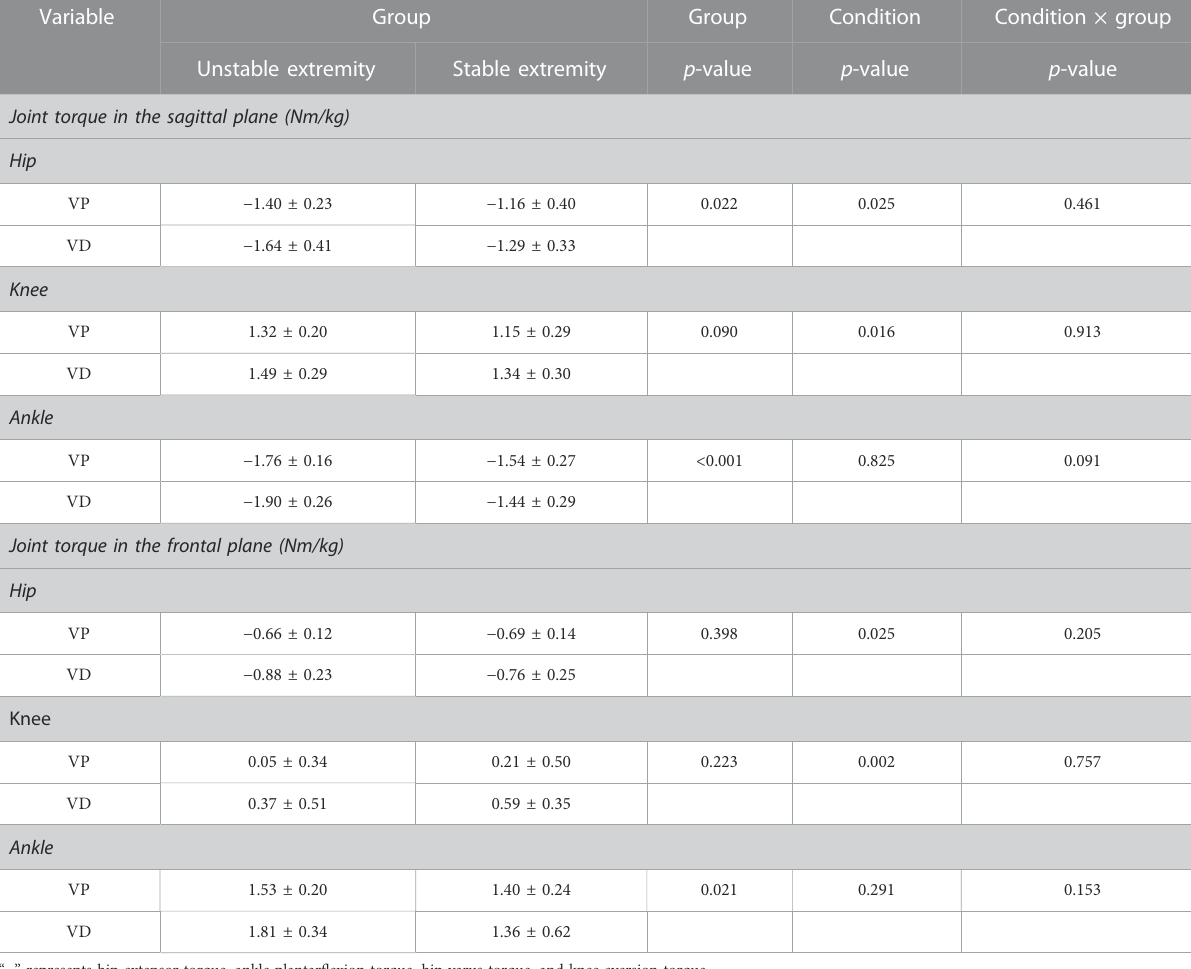
TABLE 3 Joint torque (hip, knee, and ankle) in the sagittal and frontal planes during landing with and without visual deprivation.